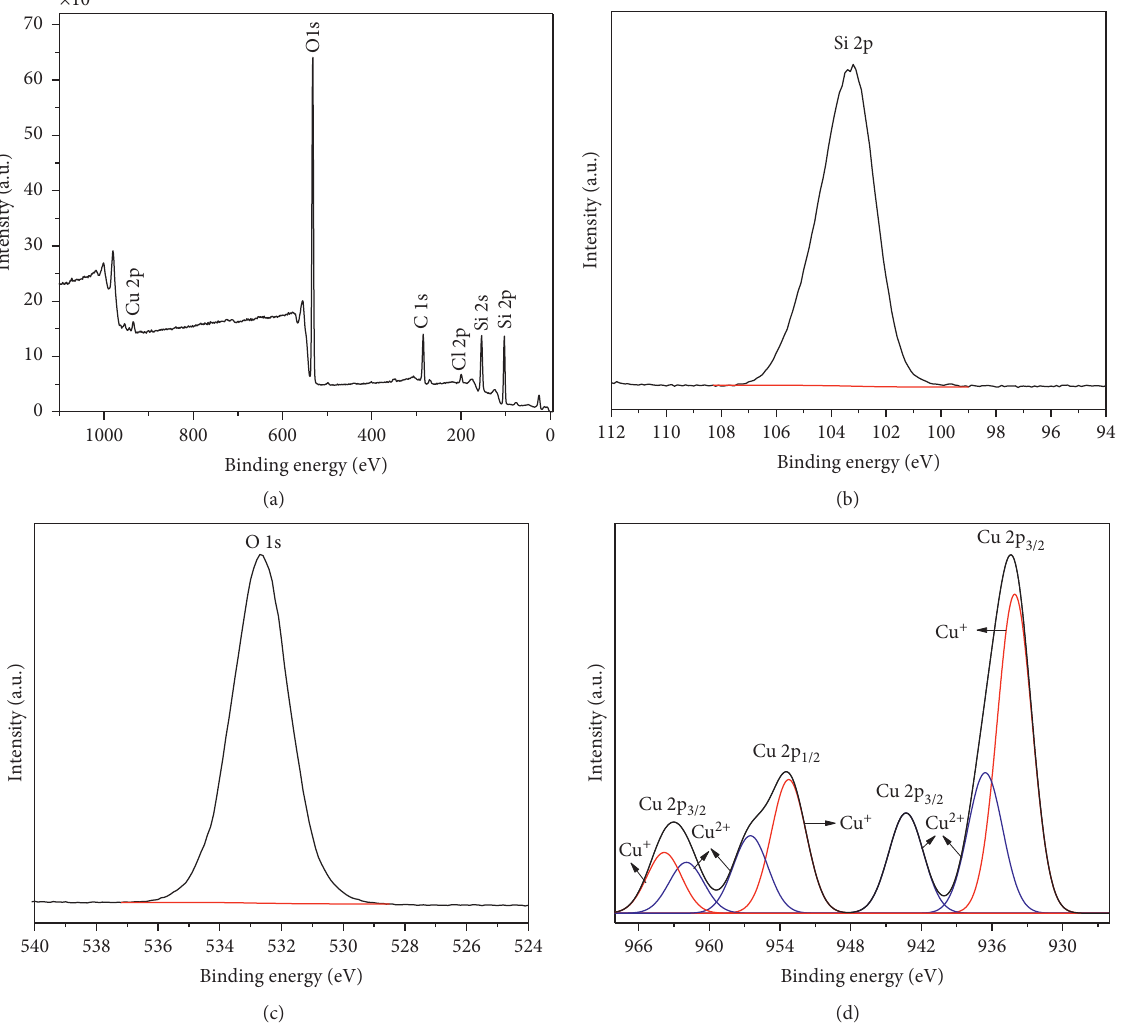
Figure 8: XPS spectra of 2CuCl/diatomite. (a) Survey XPS spectrum of 2CuCl/diatomite, (b) XPS spectrum of Si 2p, (c) XPS spectrum of O 1s, and (d) XPS spectrum of Cu 2p.